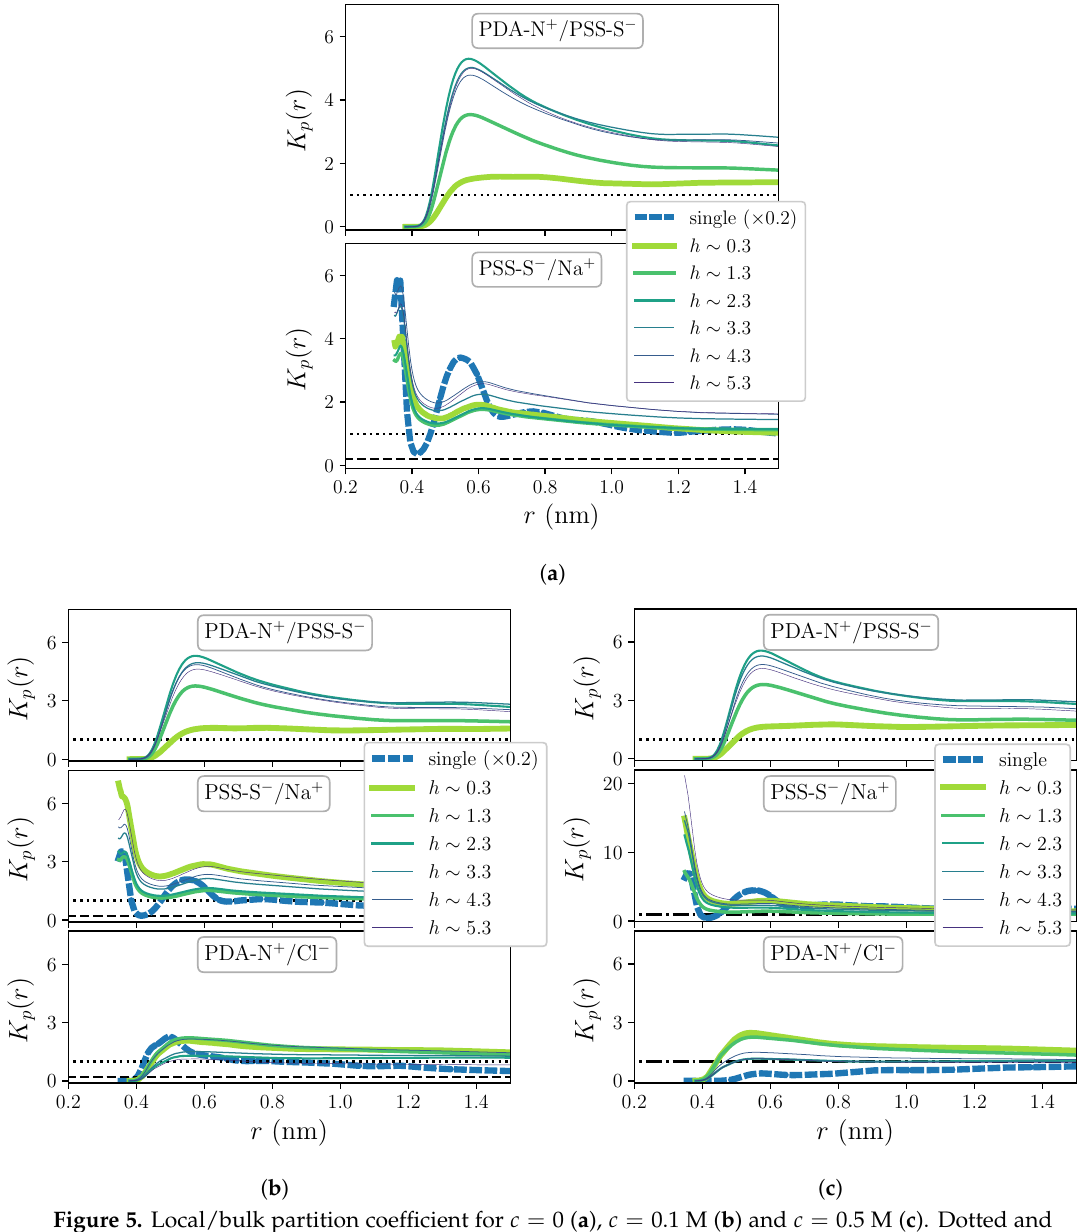
Figure 5. Local/bulk partition coefficient for c = 0 ( a ), c = 0.1 M ( b ) and c = 0.5 M ( c ). Dotted and dashed horizontal lines indicate the limit between accumulation/exclusion behavior for OEM and single chain systems, respectively, when their curves are plotted in different scales; dashed-dotted horizontal lines indicate the same limit for both systems when their curves are in the same